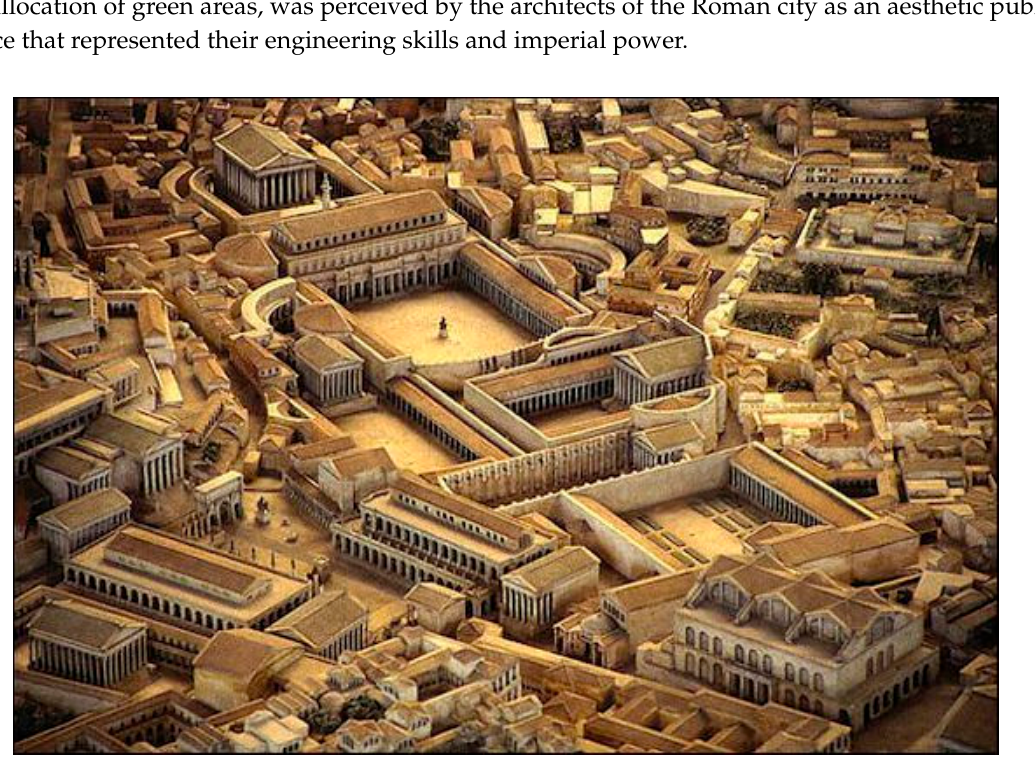
Figure 2. A model of Ancient Rome: The fully saturated built landscape of the city. Source: https://www.pinterest.com/pin/525654587726903551/.